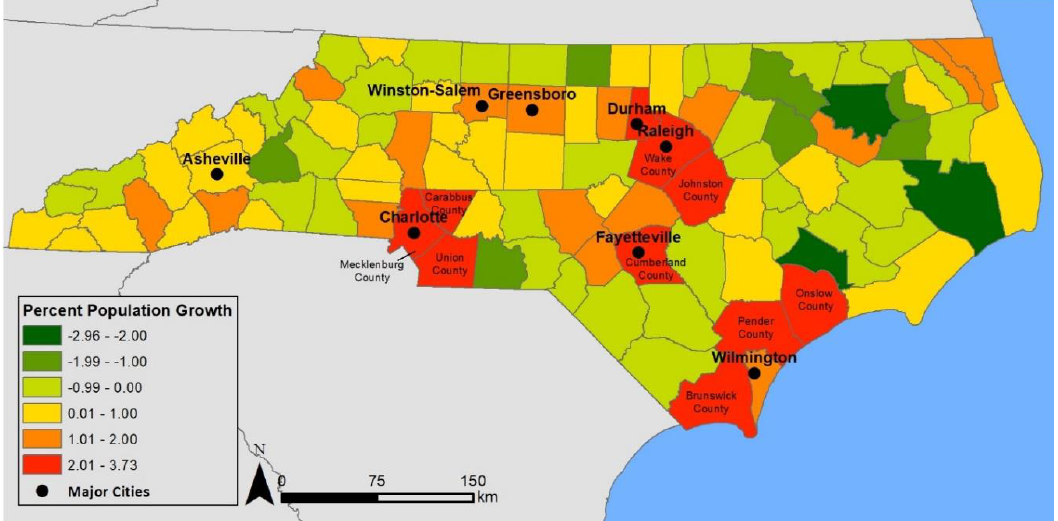
Figure 2. North Carolina population change (2016 to 2017). (Data source: US Census).